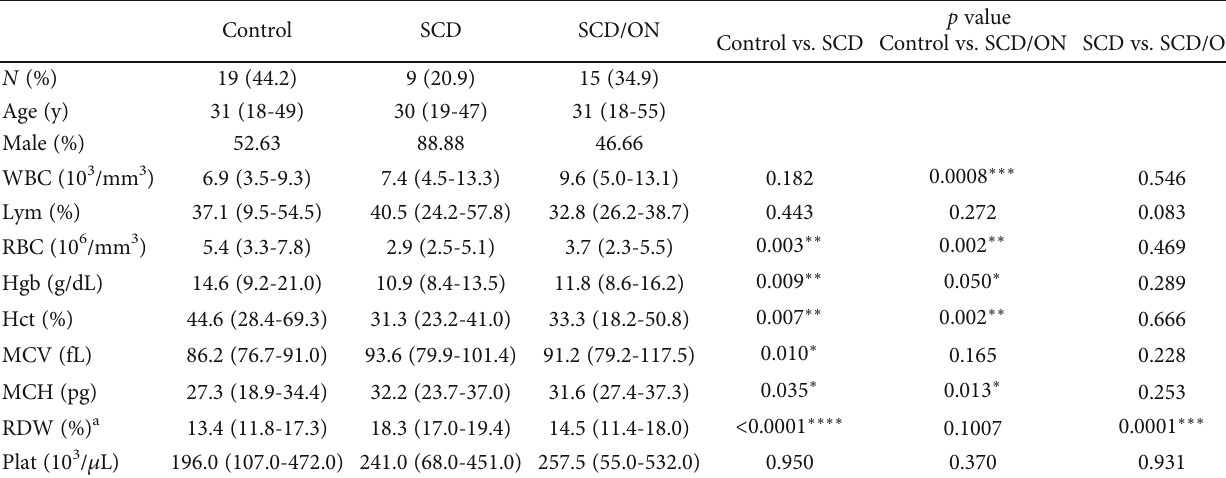
Table 1: Demographic and hematologic pro fi les for peripheral blood, from the control, SCD, and SCD/ON groups. p value Control SCD SCD/ON Control vs. SCD Control vs. SCD/ON SCD vs.